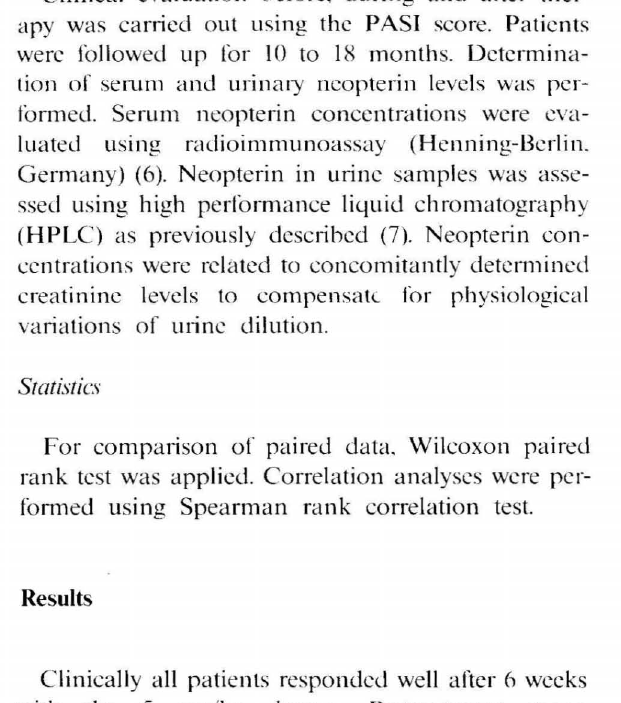
Fig.ure I. PASI-seores and serum and urine neopterin levels: 7 palienls with severe psoriasis hefore (C ) . during (I; last mea surement hefore withdrawal) anJ after (2) therapy with cy closporin A. MeJian and 25th-75th percentiles arc shown. *p<O.05. Wilcoxon paired rank